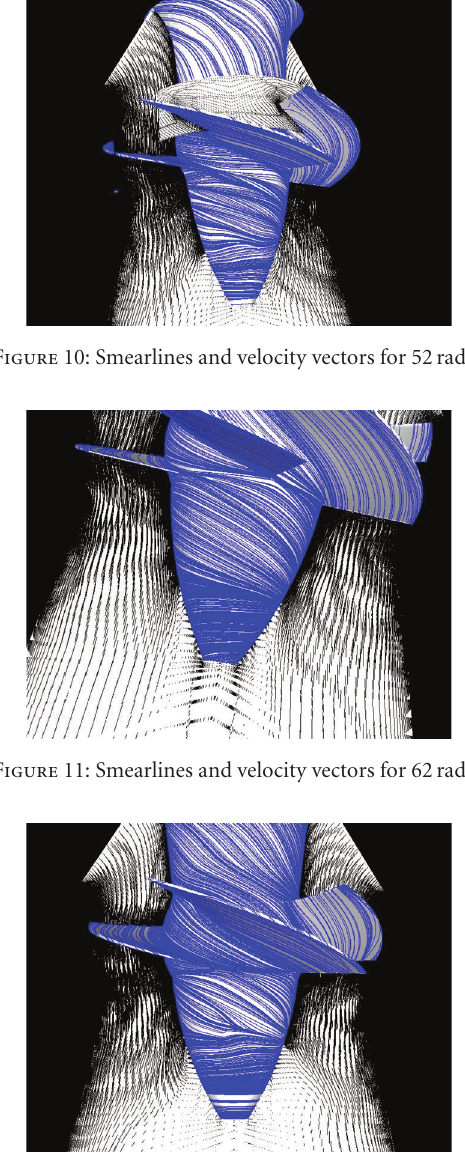
Figure 12: Smearlines and velocity vectors for 72rad /